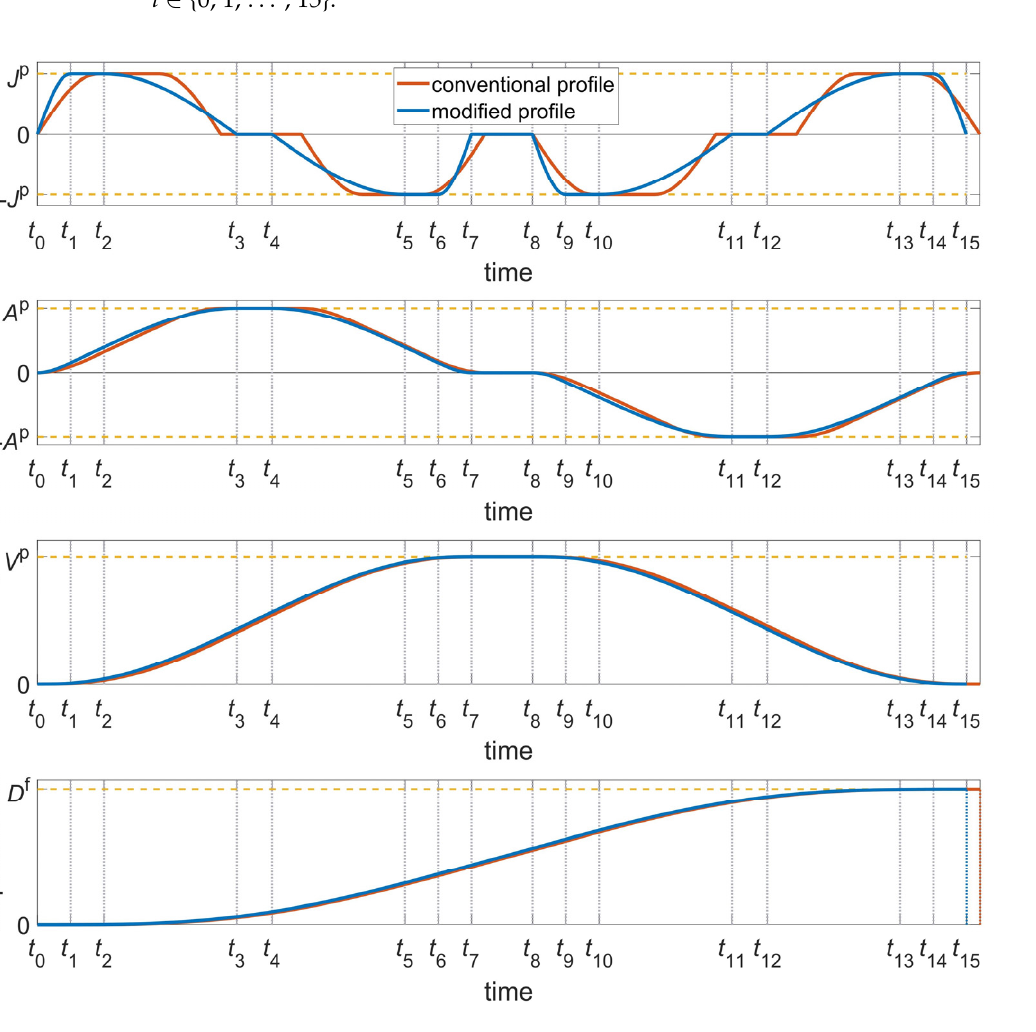
Figure 1. Jerk, acceleration, velocity and displacement profiles of the proposed trajectory model.